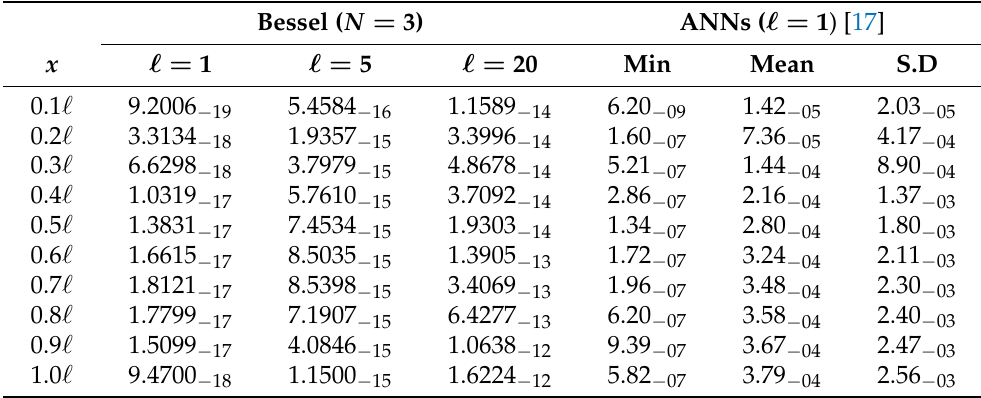
Table 1. The comparison of (absolute) errors in the Bessel matrix approach in Example 1 using N =